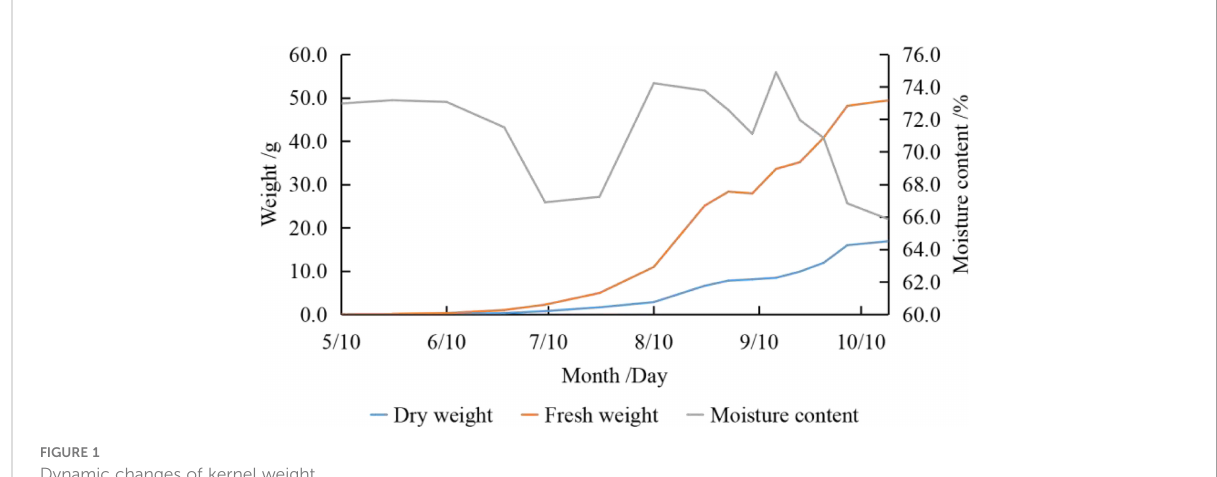
FIGURE 1 Dynamic changes of kernel